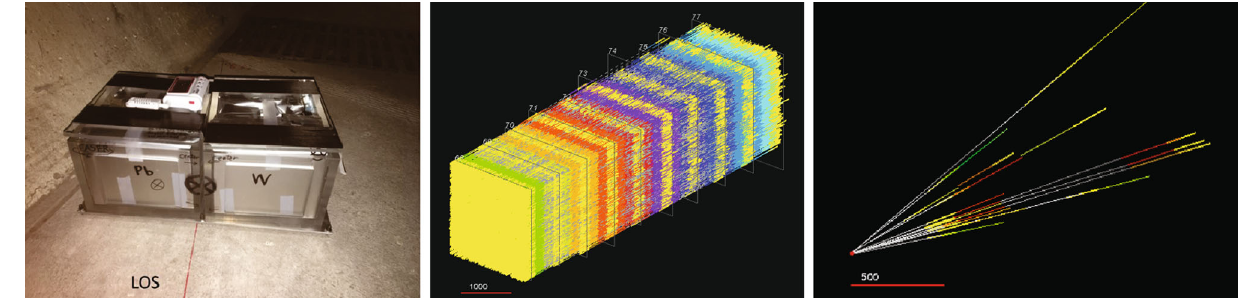
A vertex found in the detector with no incoming charged track. The ver- tex axis is compatible with the beam direction. The red scale bars in the center and right figures are 1000 µ m and 500 µ m long, respectively